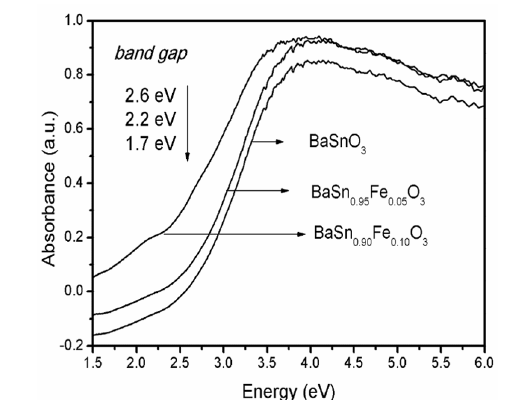
Fe O (0; 0.05 and 1-x x 3